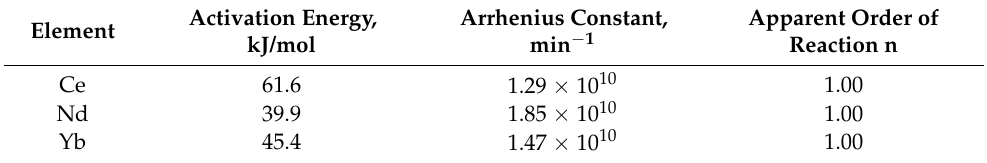
Table 9. Kinetic parameters of carbonate dissolution of lanthanide